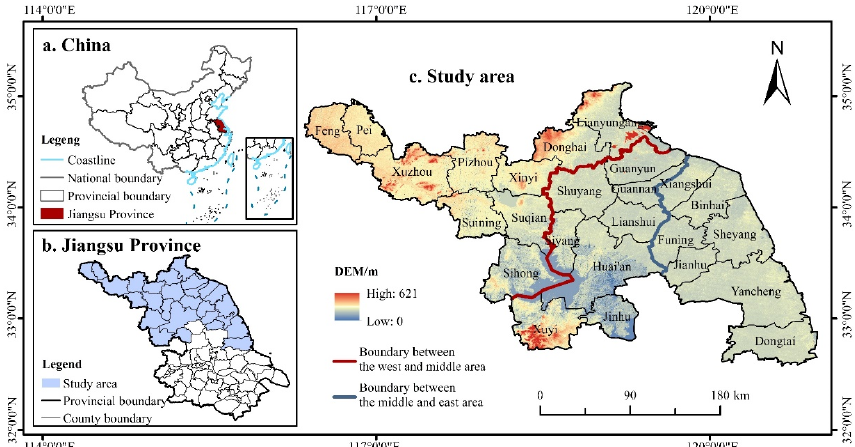
Figure 1. Location of the study area.